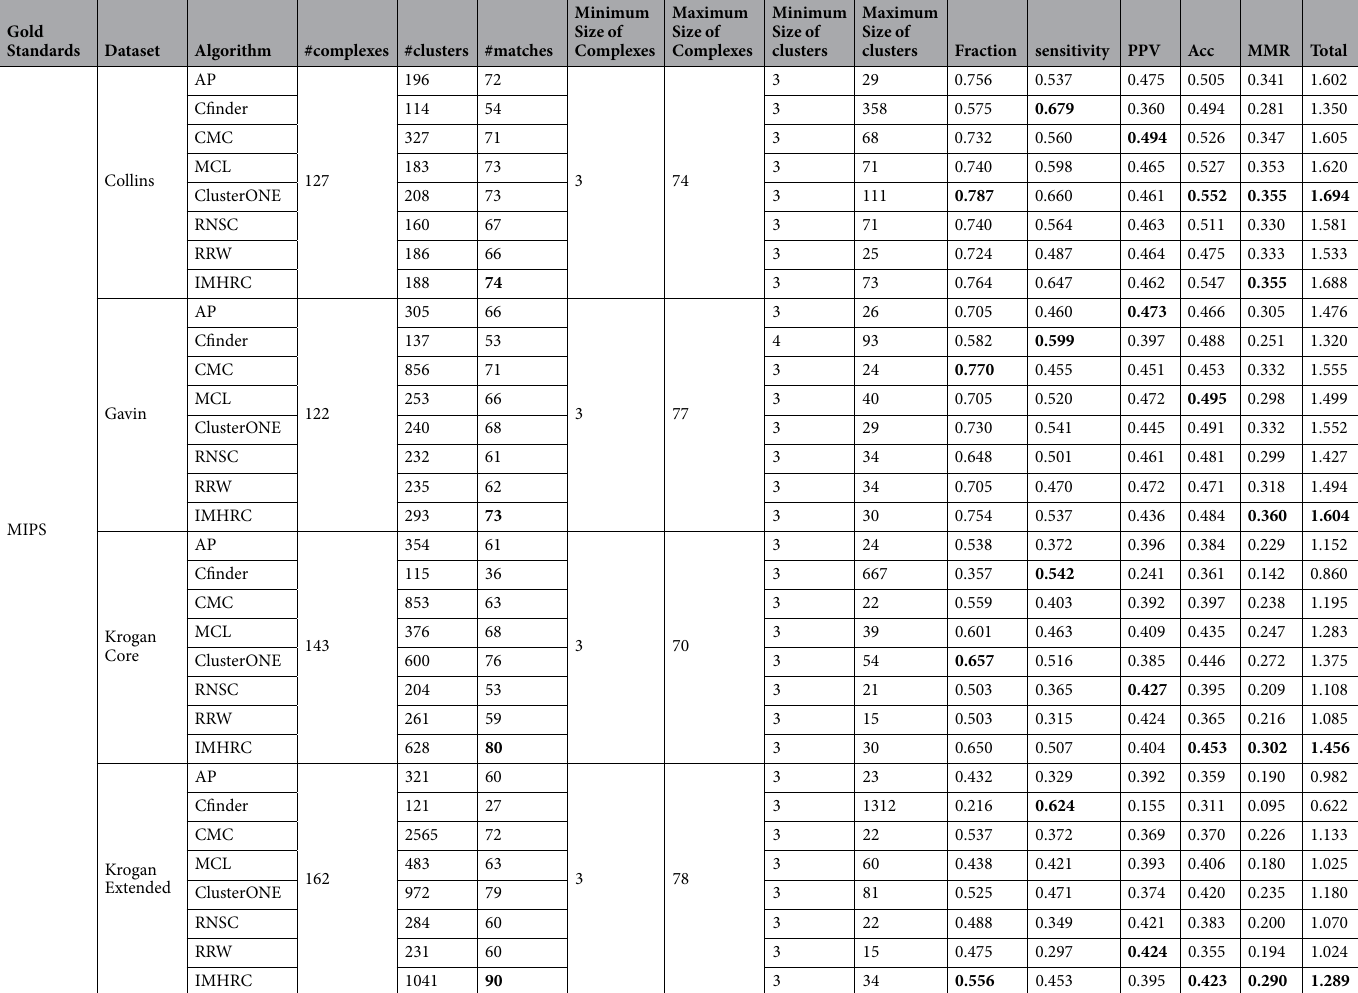
Table 5. Experimental results and performance comparison of all methods used in this paper on the MIPS gold standard. The bold values show the best results in comparison with other